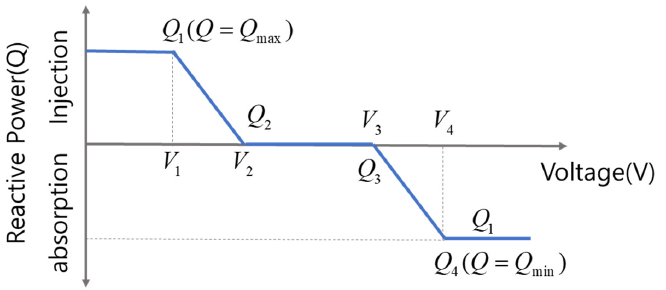
Figure 2. Example of Volt/Var control.